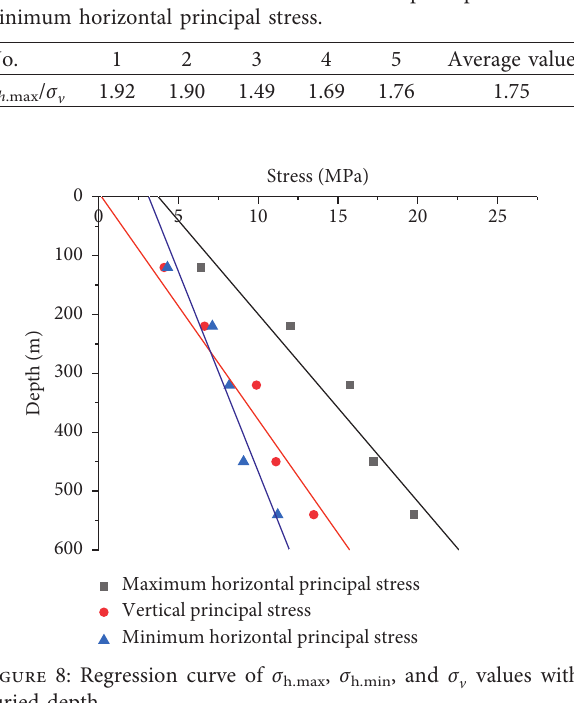
h.max , σ h.min , and σ v values with